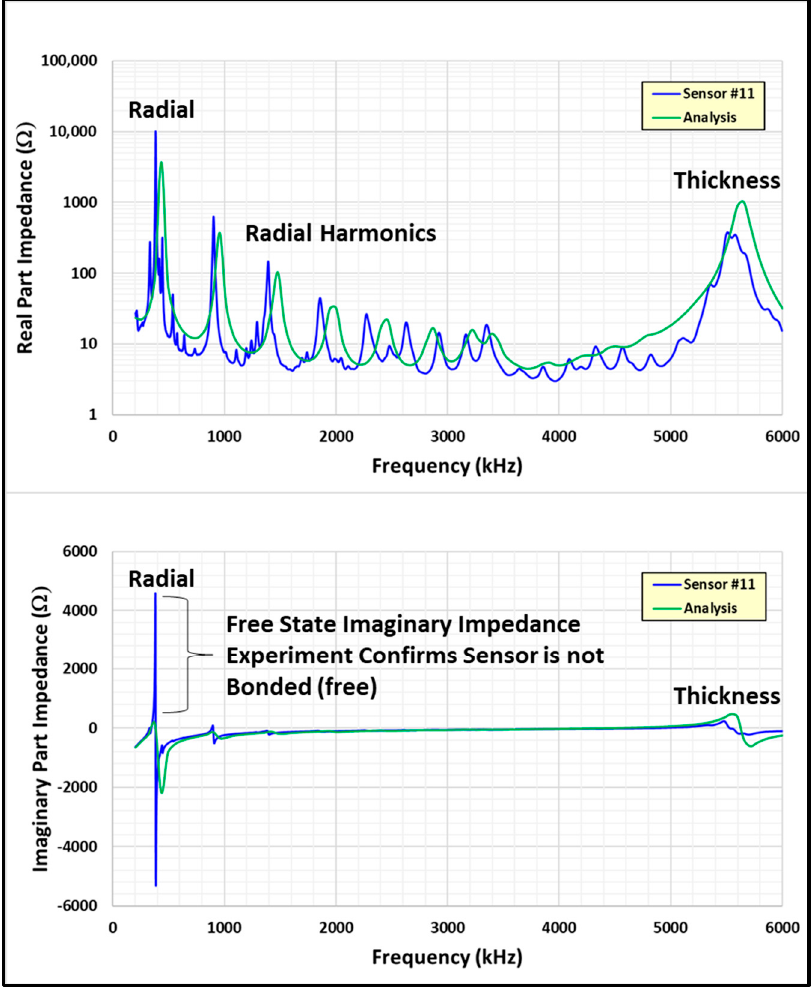
Figure 20. Free sensor impedance sensor #11 vs. analysis.